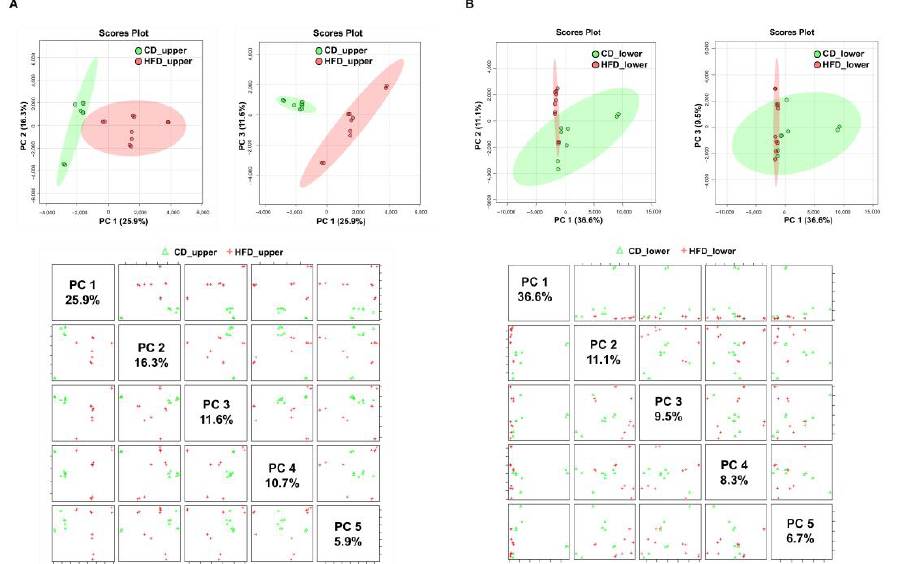
Figure 4. High-throughput deep proteomics of intestinal epithelial cells (IECs) in the upper and lower small intestines. ( A ) Principal component analysis (PCA) for proteomes of IECs from the upper small intestine. ( B ) PCA for proteomes of IECs from the lower small intestine. Green and red areas show 95% confidence regions.